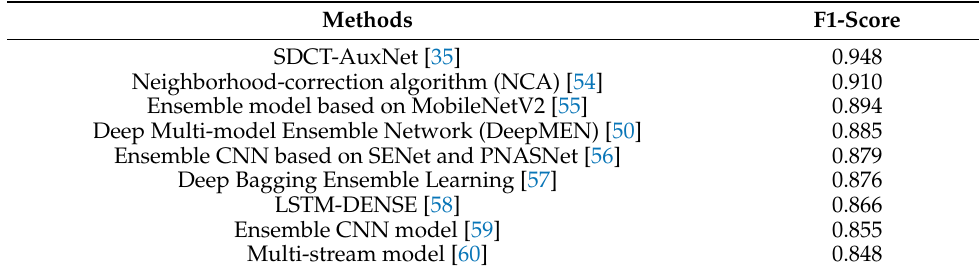
Table 8. Methods with the top entry of C-NMC 2019